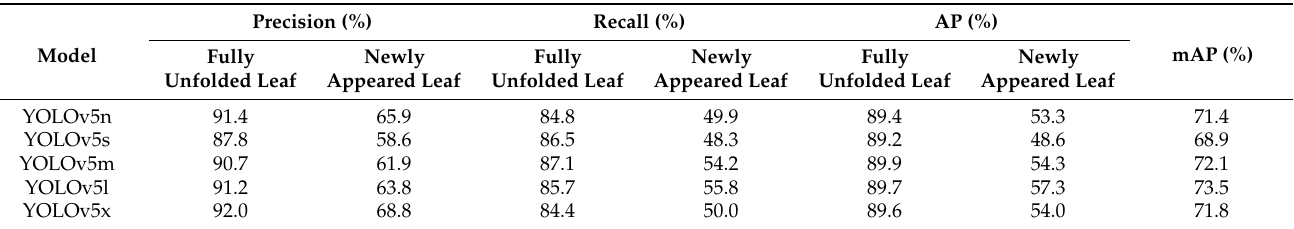
Table 4. Test results of leaf detection with different object detection